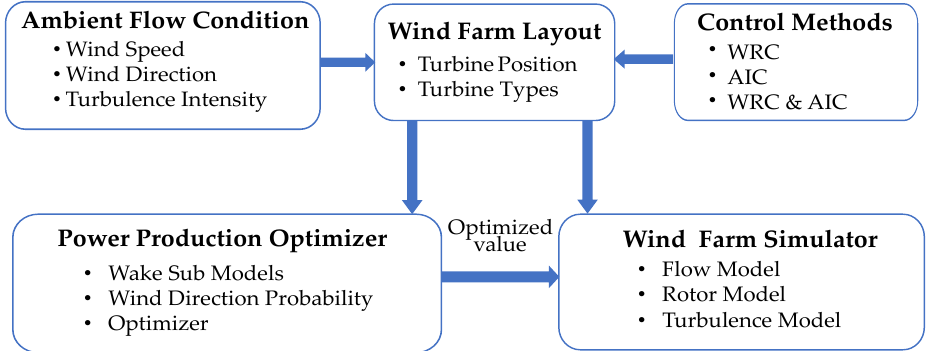
Figure 8. Flowchart of dynamic wind farm